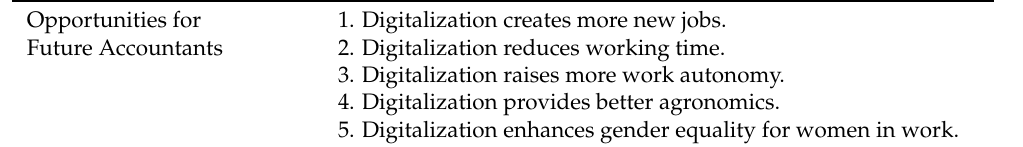
Table 2. List of items. Opportunities